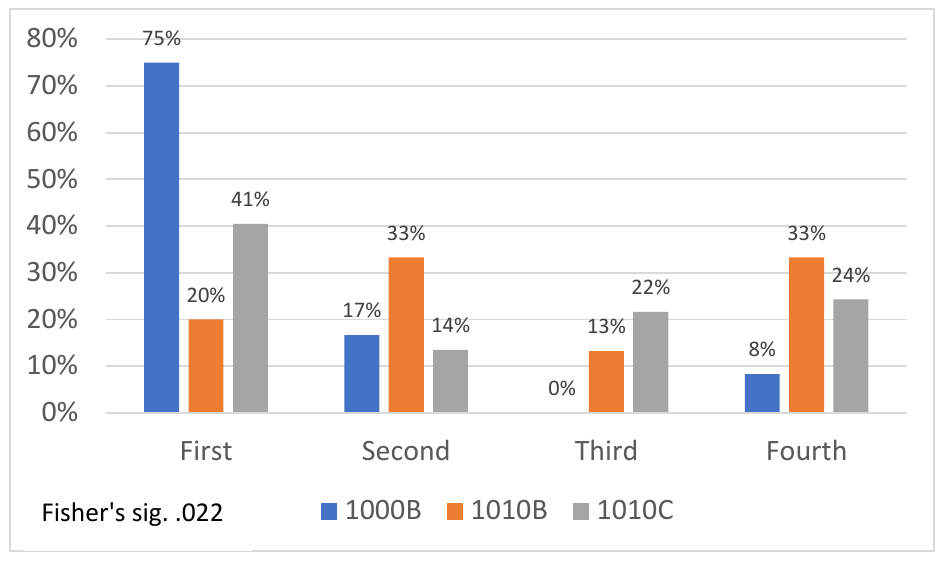
FIGURE 4. QUARTILE DISTRIBUTION OF HIGH SCHOOL GRADES BY COURSE